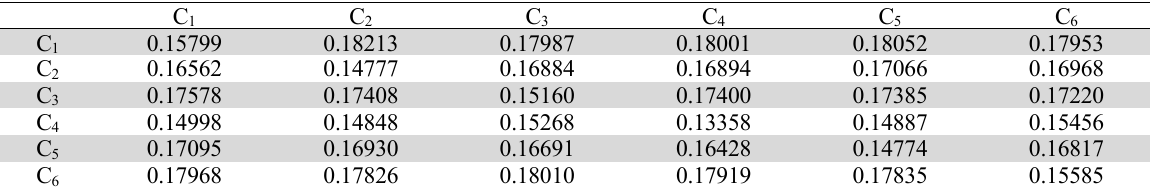
Criteria were obtained by taking into account dependence by combining the results through the relation W ɛ = B ×